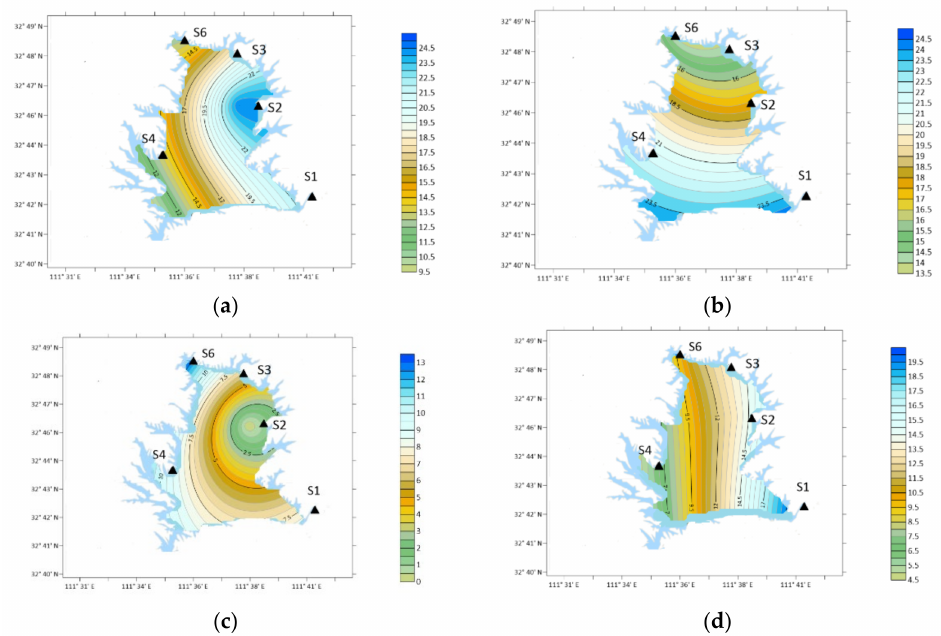
Figure 8. Spatial variation of PA concentration. ( a ) Winter; ( b ) spring; ( c ) summer; ( d ) autumn. The concentration of PA was the highest in S2 (Industrial Area) in the southwest in winter. In spring and autumn, the concentration was the highest at S1 (Urban Area). In summer, the concentration was the highest at S4 (Orange yard) position.